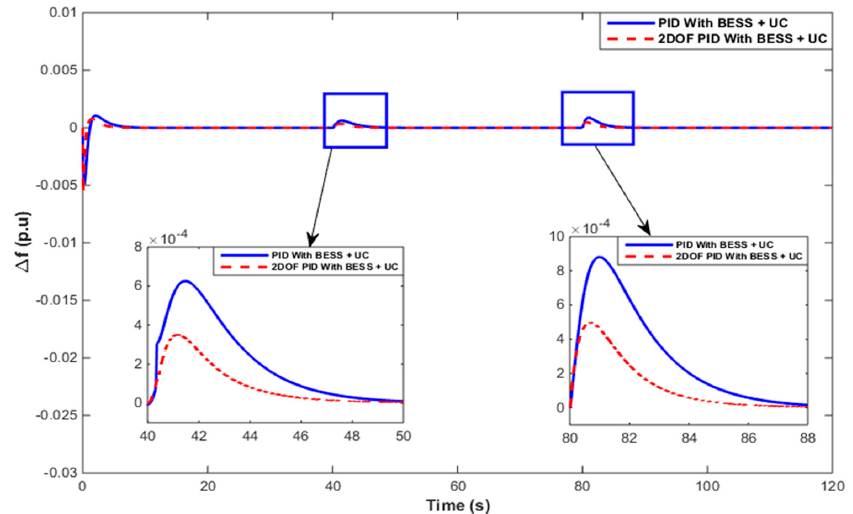
Figure 14. Comparative performances of the frequency responses of BESS (case 1) and BESS + UC (case 2) with the FPA-optimized PID- and 2DOF-PID-controller-based hybrid energy systems.